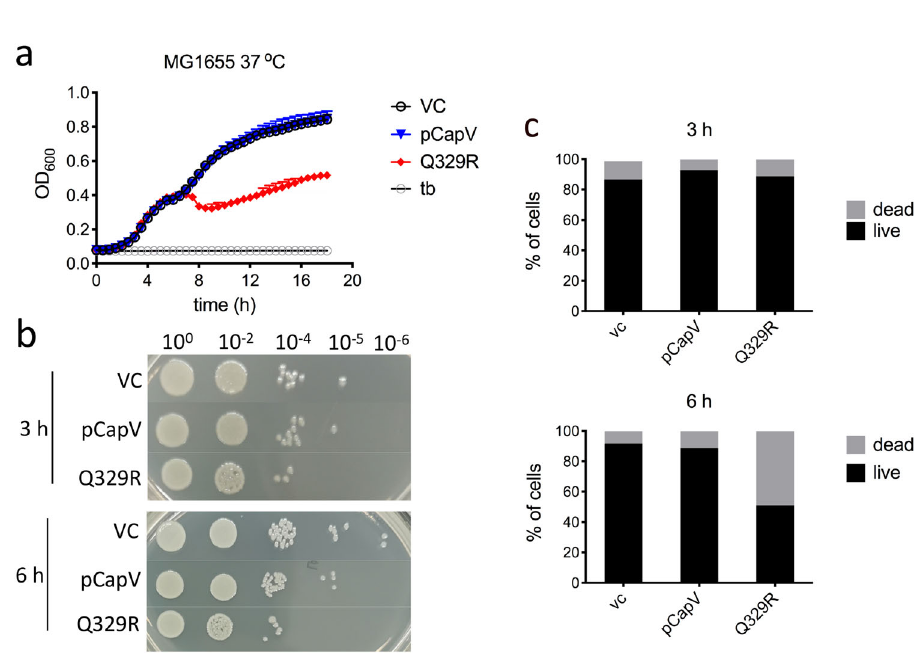
Fig. 6 CapV Q329R , but not CapV is cytotoxic to E. coli MG1655 in the early stationary phase. a Growth curves of E. coli MG1655 upon CapV and CapV Q329R overexpression induced by 0.1% L -arabinose in TB at 37 °C. Each data point represents the mean ± SD of six biological replicates. tb = TB medium. b Colony-spotting assay on agar plates. Cells were grown at 37 °C and harvested at different time points. Cell